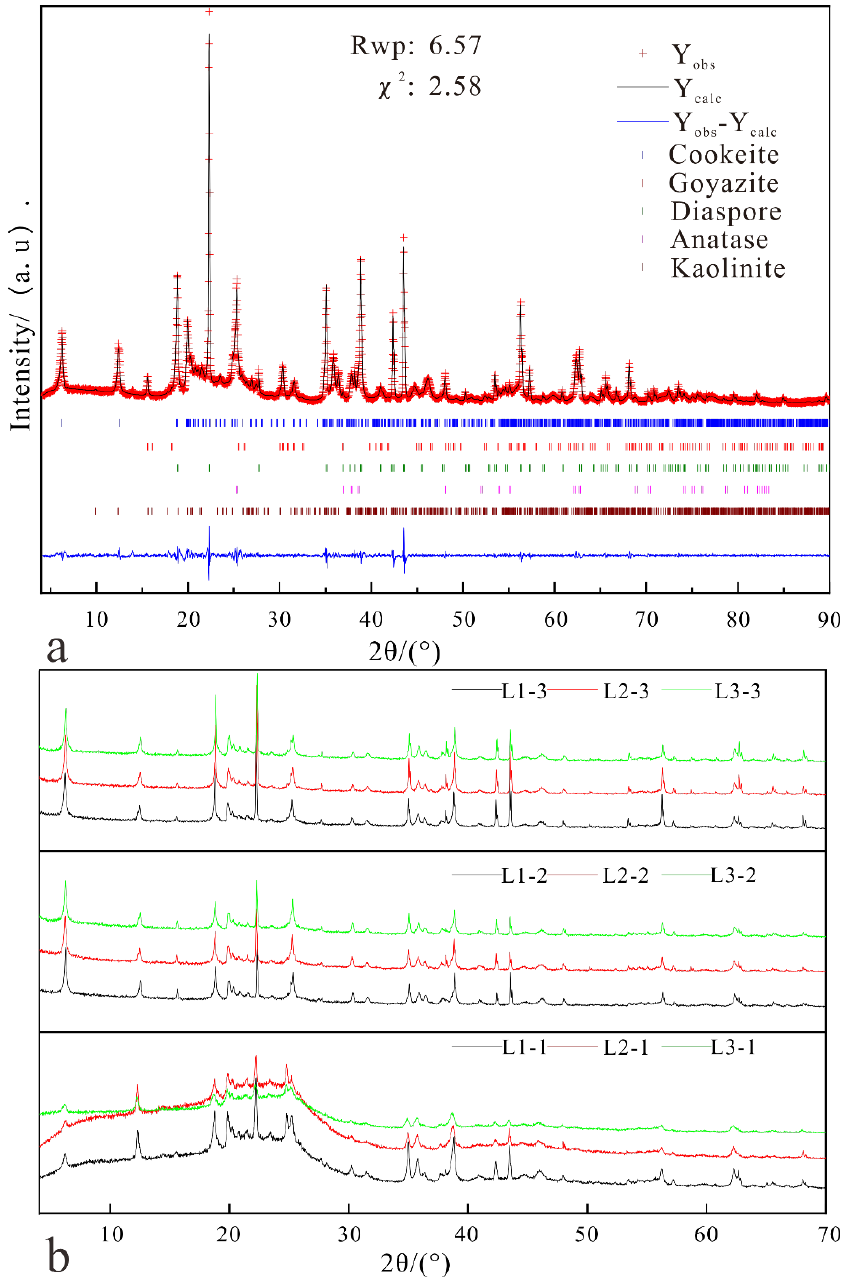
Figure 2. XRD patterns of the sample Y1 refining the mineral cell parameters using Rietveld refine- ment ( a ) and density-fractionated samples ( b ). Y obs : observed value, Y calc : calculated value.